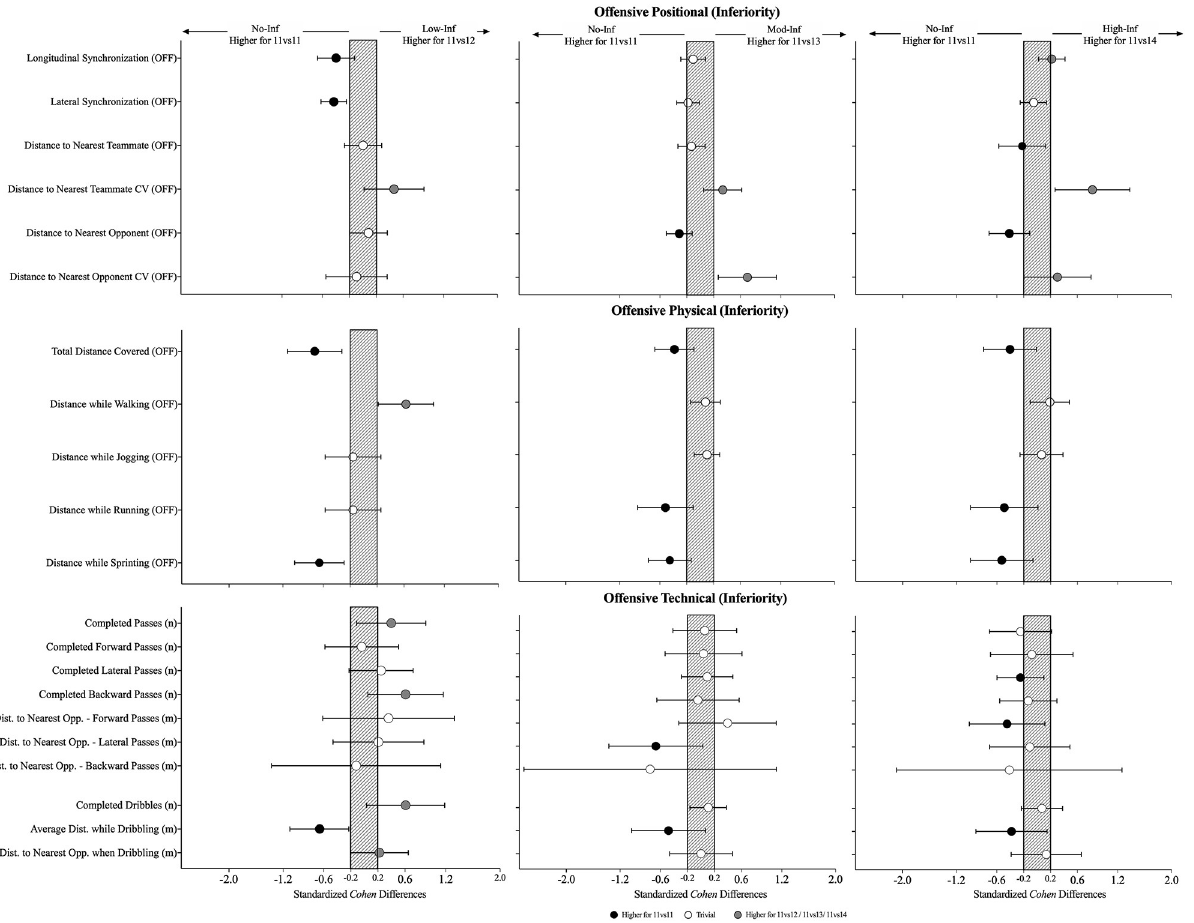
Fig 4. Standardised (Cohen) differences in positional, physical and technical variables when playing in inferiority (opposition-perspective) during the offensive phase. Error bars indicate uncertainty in the true mean changes with 90% confidence intervals. OFF = offensive; Dist = distance; Opp = opponent; n = number; m =